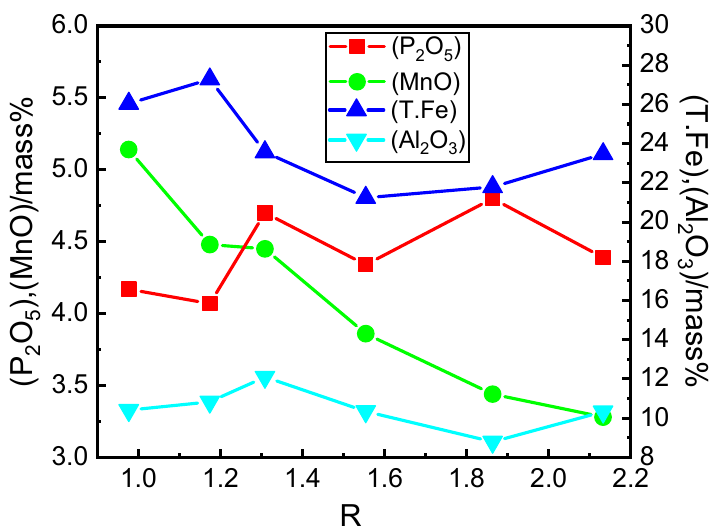
Figure 3. Effect of the basicity of the dephosphorization slag on the P 2 O 5 , MnO, T.Fe, and Al 2 O 3 contents in slag.